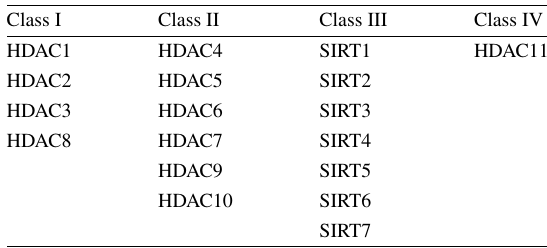
Classification of HDAC